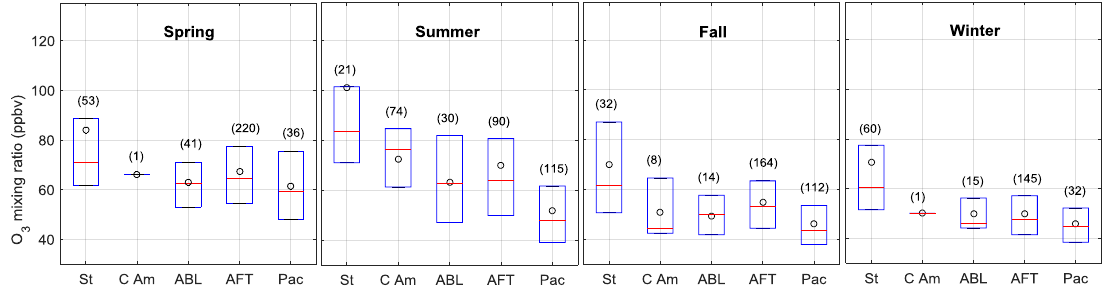
Figure 10. Box plot of the ozone mixing ratios measured within the air masses arriving at TMF at 9km for the five identified categories (see text for details) and the four seasons. The black dot represents the mean value, the red line is the median and the box limits correspond to the 25th and 75th percentiles. The numbers between parentheses indicate the number of associated